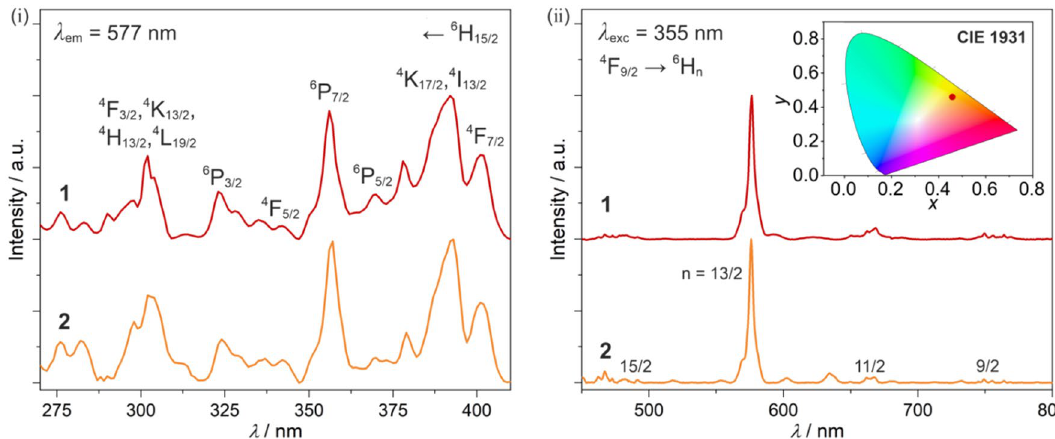
Figure 3. Solid-state room-temperature photoluminescence of 1 and 2 : excitation spectra for the emission at 577 nm with the indicated f-f electronic transitions (i), and the respective emission spectra for the excitation wavelength of 355 nm with the indicated f–f electronic transitions (ii), together with the resulting color (identical for 1 and 2 ) presented on the CIE 1931 chromaticity diagram shown in the